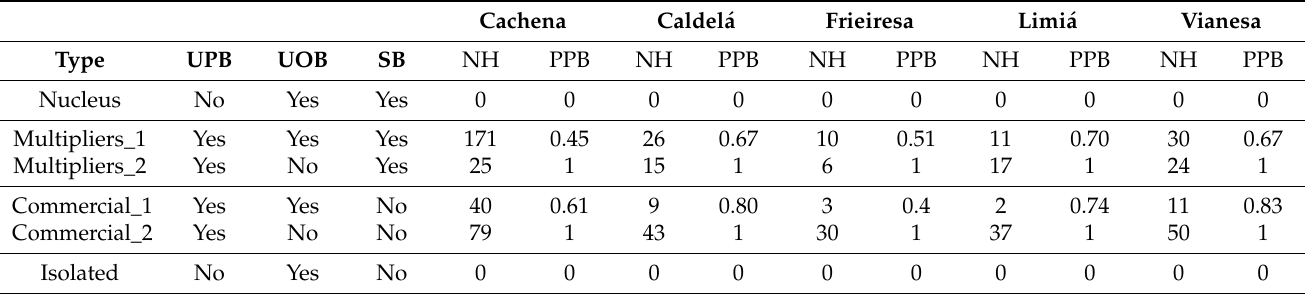
Table 5. Number of herds of the five Galician bovine breeds classified as Nucleus, Multiplier, Commercial and Isolated, according to Robertson (1953). UPB: Herds using purchased sires; UOB: Herds using their own sires; SB: Herds selling bulls used as sires; NH: Number of herds per herd type; PPB: Percentage of purchased